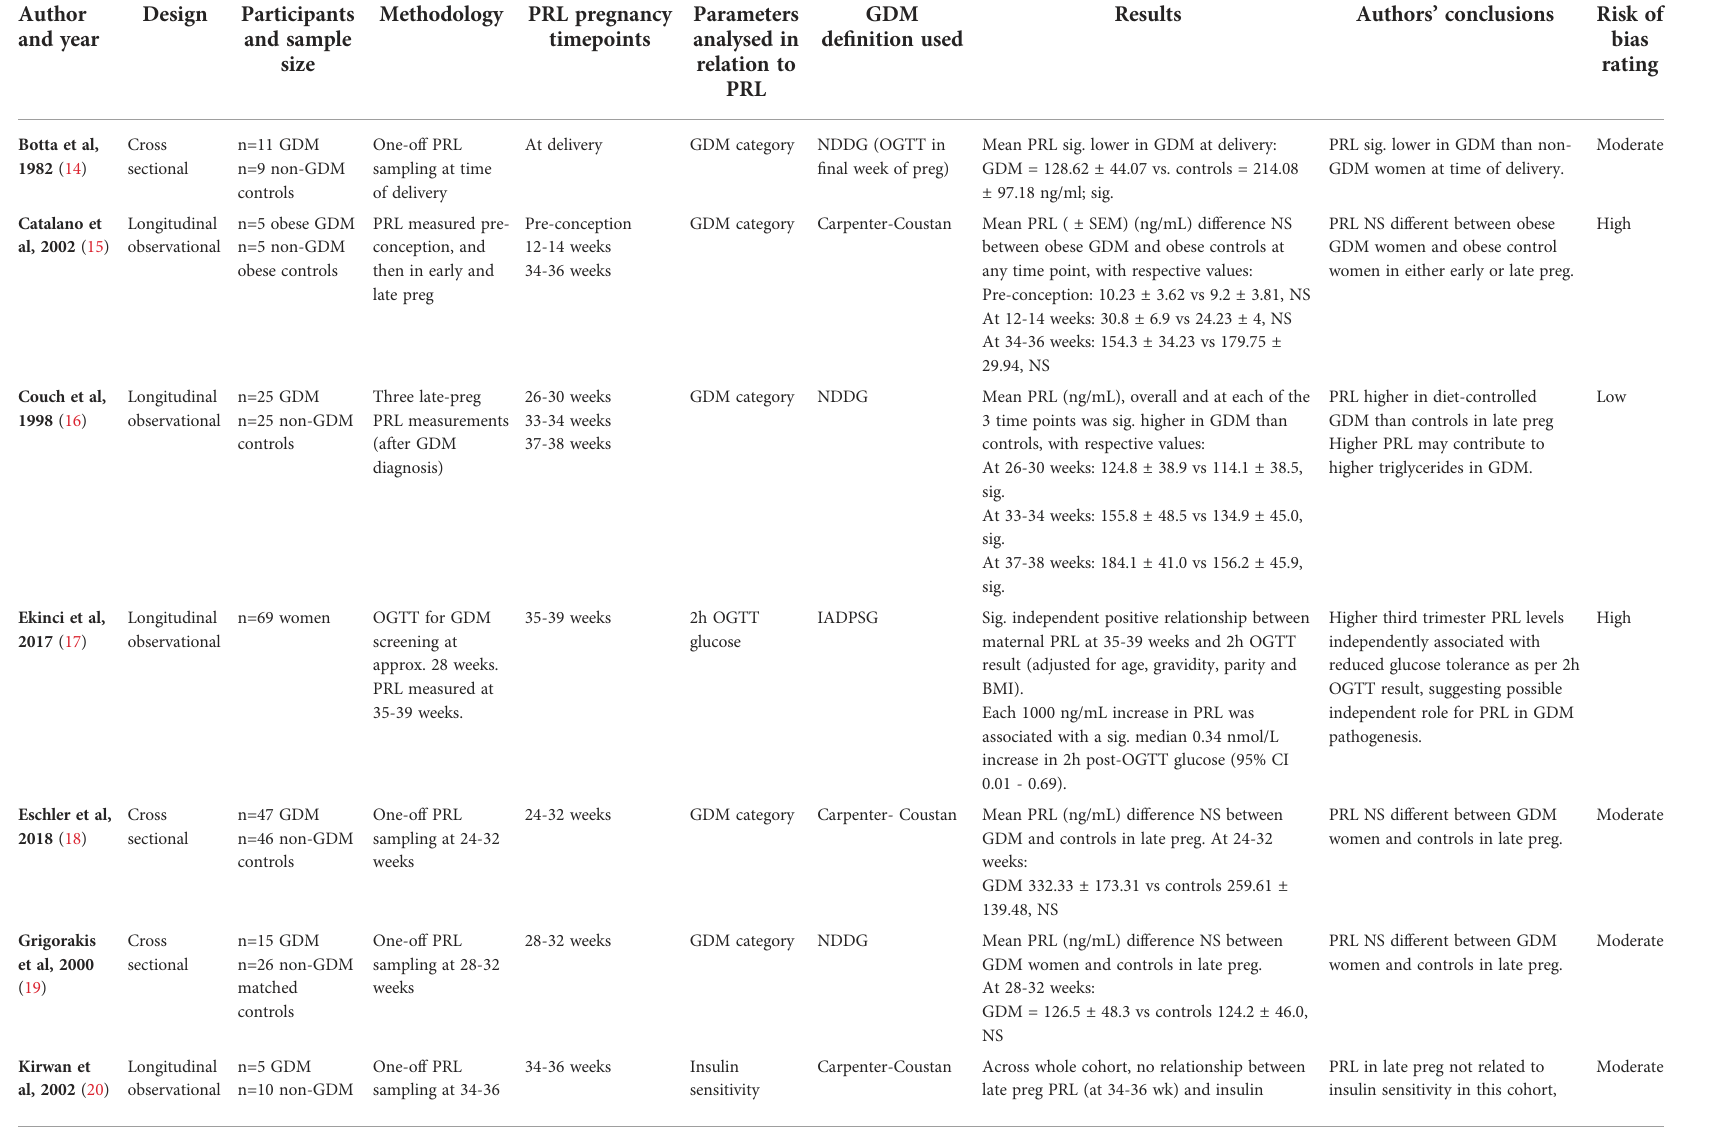
TABLE 1 Studies examining PRL in relation to maternal GDM status, GDM risk, and/or continuous measures of maternal glycaemia in pregnancy - 15